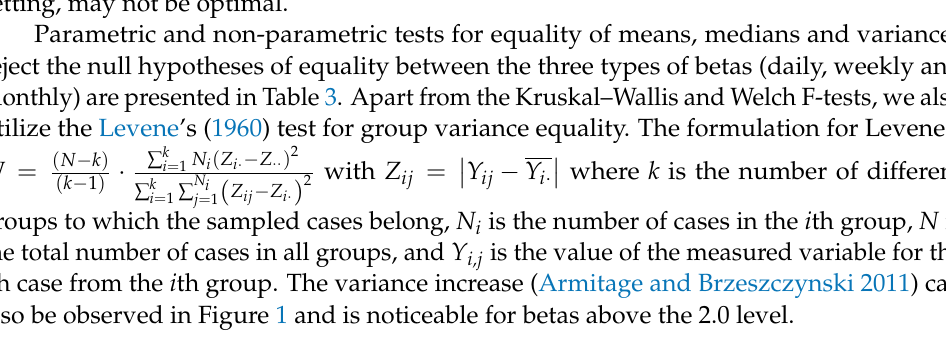
Table 3. Tests for equality of means and variance homogeneity (daily, weekly and monthly